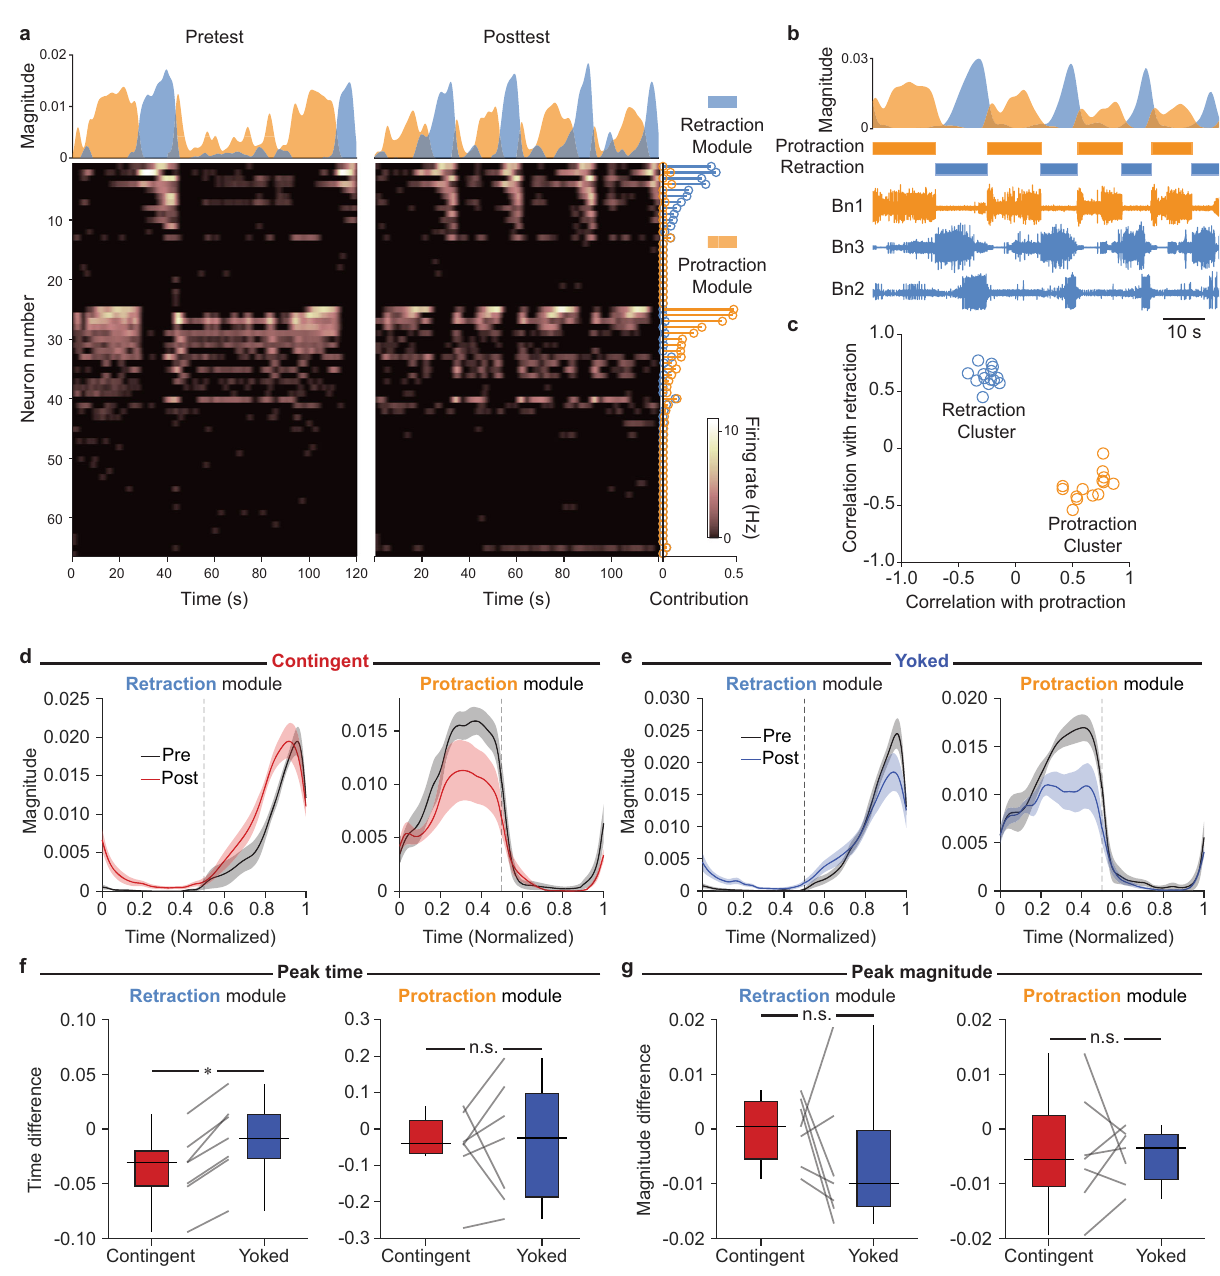
Fig. 3 Contingent training advances recruitment of the retraction, but not the protraction, motor module. a Example NNMF of population activity into two modules. Area plots (top) show module recruitment over two 120-s recording periods. Stem plots (right) indicate the module contributions by each neuron. Heat maps (bottom) show activity. Neurons are sorted by the difference between contributions to each module. b Example of module recruitment (top) during a sequence of BMPs. BMP phases (middle) were labeled based on nerve recordings (bottom). c Correlation between module recruitment and BMP phases across animals. Modules formed two clear clusters — one correlated with retraction, and the other with protraction. d Module recruitment before (black) and after (red) contingent training, shown over the course of a BMP normalized for phase duration. Dashed lines represent the transition between protraction and retraction phases. Lines and shading represent mean and standard error. e Same as panel d , but for yoked preparations. f Temporal shift following training. Recruitment of the retraction module was signi fi cantly advanced ( P = 0.02, W = 28, N = 7; medians: contingent = − 0.03, yoked = − 0.01). No signi fi cant difference was observed for the protraction module ( P = 0.81, N = 7). g Change in magnitude of peak module recruitment was not statistically signi fi cant for either retraction ( P = 0.30, N = 7) or protraction ( P = 0.81, N = 7) modules. Individual datums represent preparations. Box plots show median (line), quartiles (box), and range (whiskers). Magnitude and contribution units throughout the illustration are normalized to the ℓ 2 norm of the time course of each module 28 .